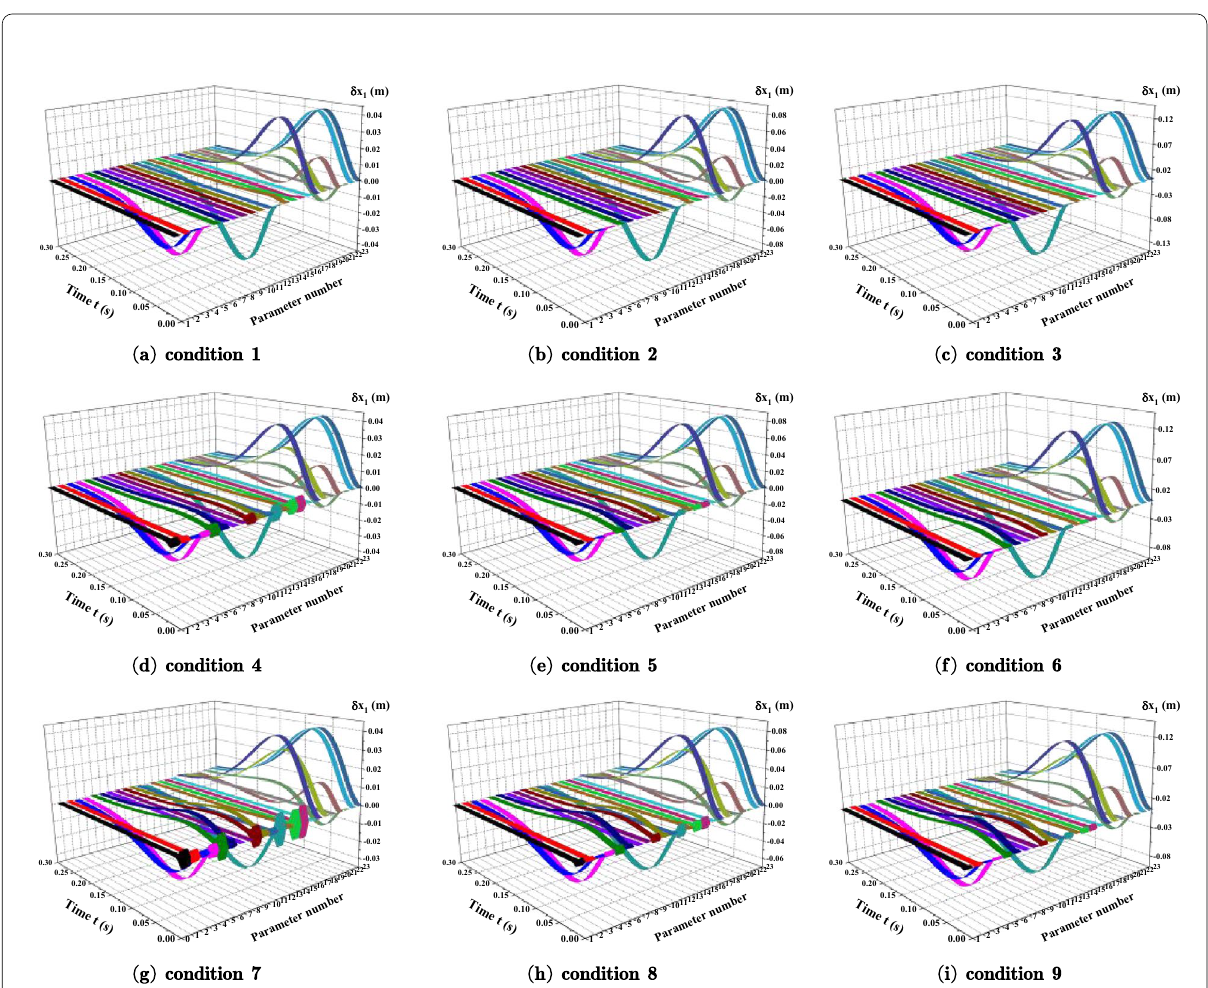
Figure 8 Change in rotation angle corresponding to each parameter under nine conditions